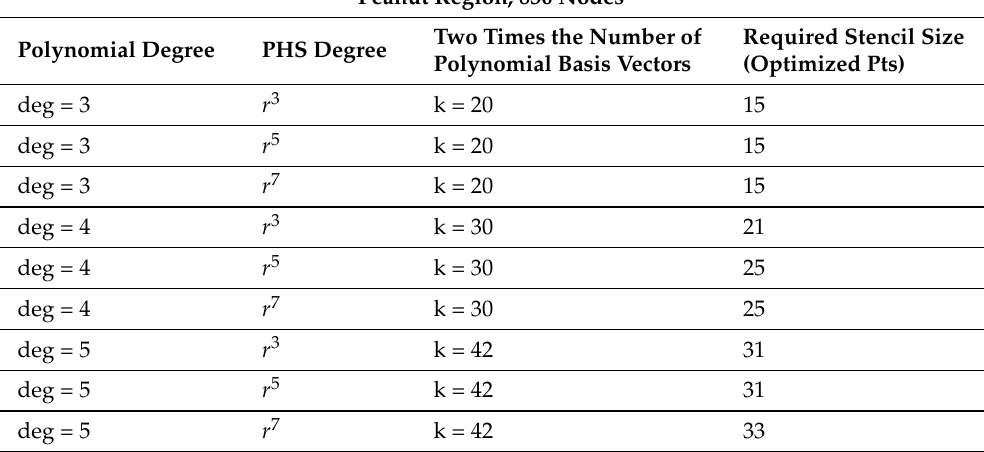
Table 3. Stencil size reduction for different selections of polynomial degree and PHS degree for the peanut